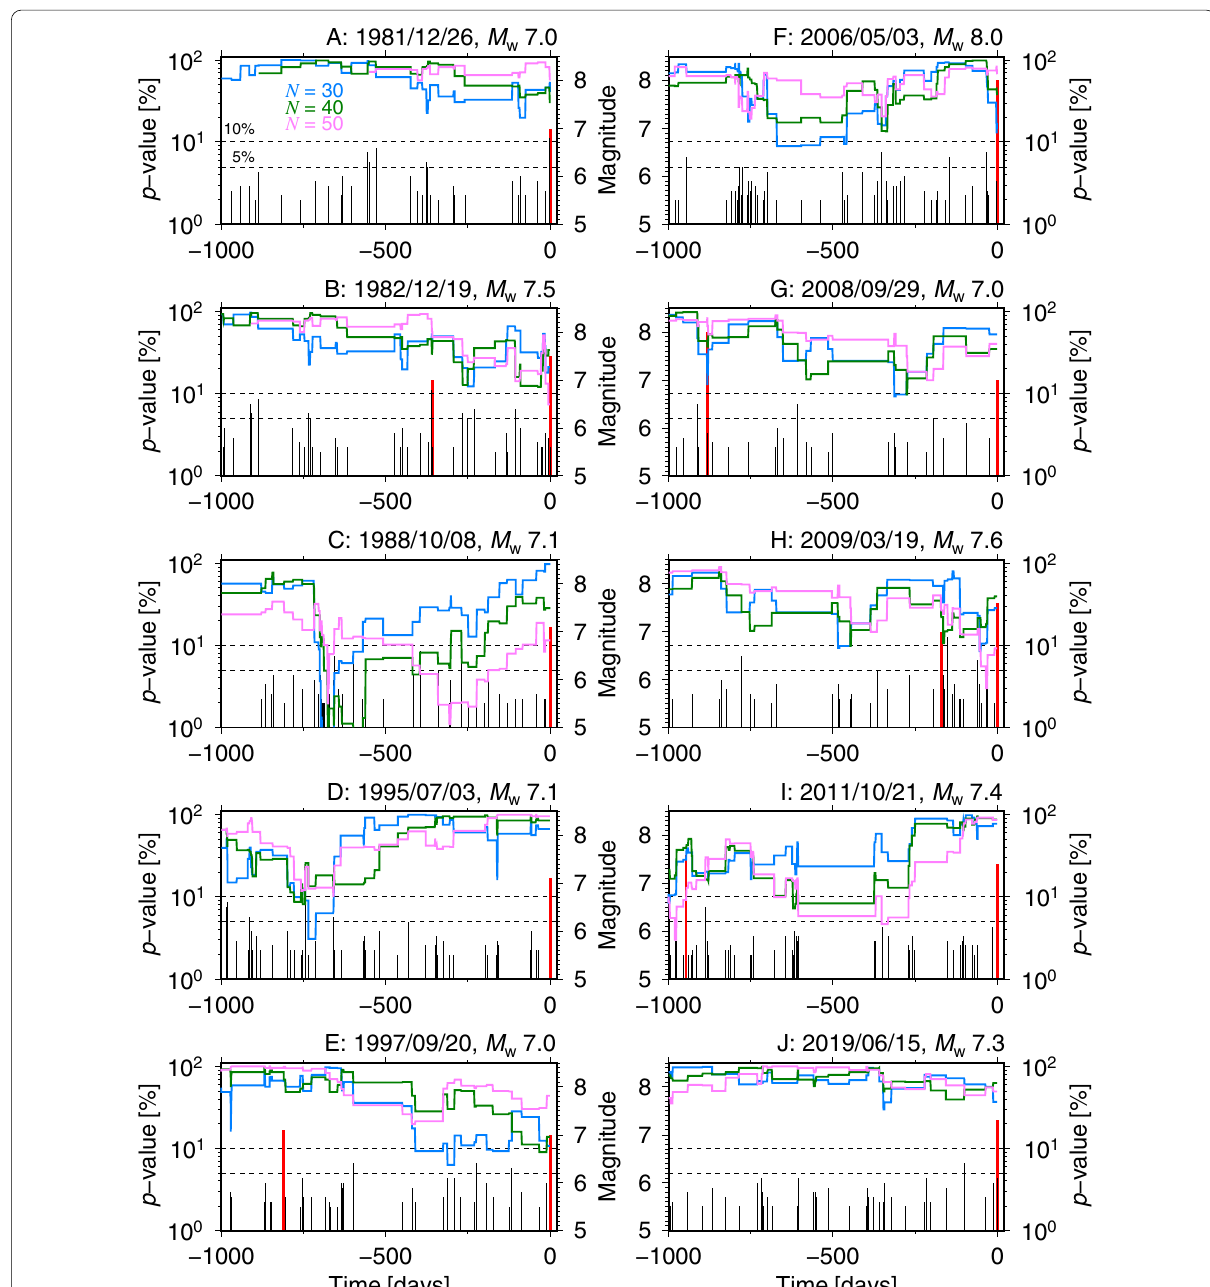
Fig. 3 As in Fig. 2, but for the 1000 days preceding earthquakes of M w